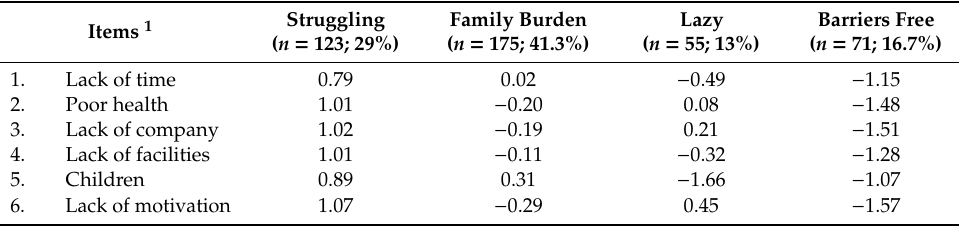
Table 3. Descriptive statistics on the 5 latent profile solution ( n = 424).